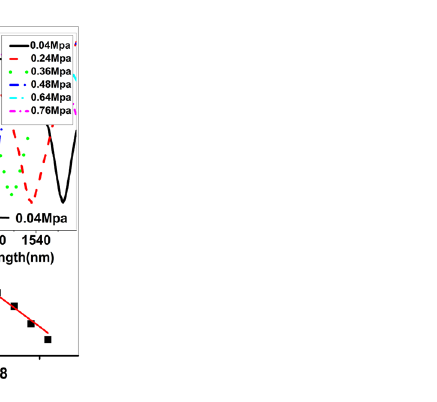
Figure 5. Schematic diagram of experimental setup.